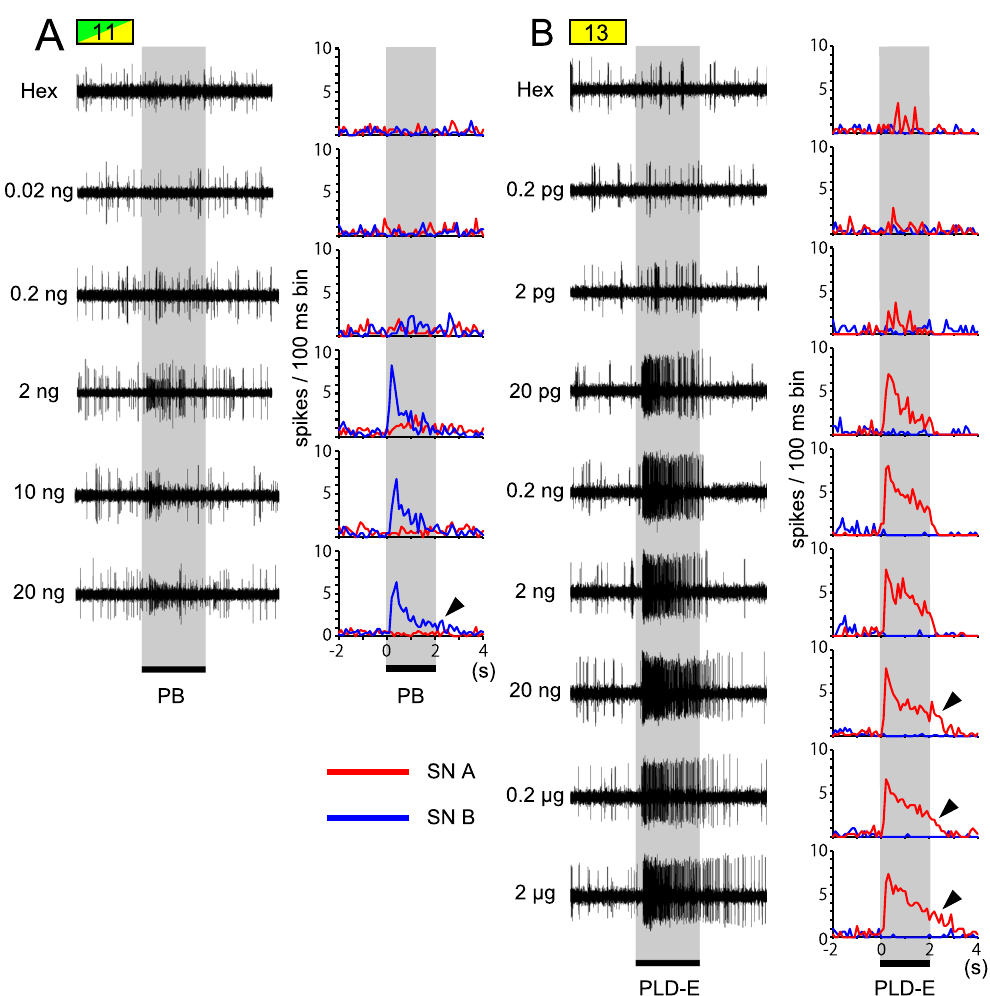
Figure 4. Temporal activity patterns of SN A and SN B that respond to sex and aggregation pheromones. ( A , B ) Temporal activity patterns of SN A and SN B to a given concentration of PB ( A ) and PLD-E ( B ). Olfactory responses (left panels) are obtained from a PB-responsive sw -A2 sensillum (A: #11 in Figs. 2D and 3F) and a PLD-E-responsive sw -A2 sensillum (B: #13 in Figs. 2D and 3F). Responses of SN A and SN B are displayed as peri-stimulus time histograms with 100 ms bins (right